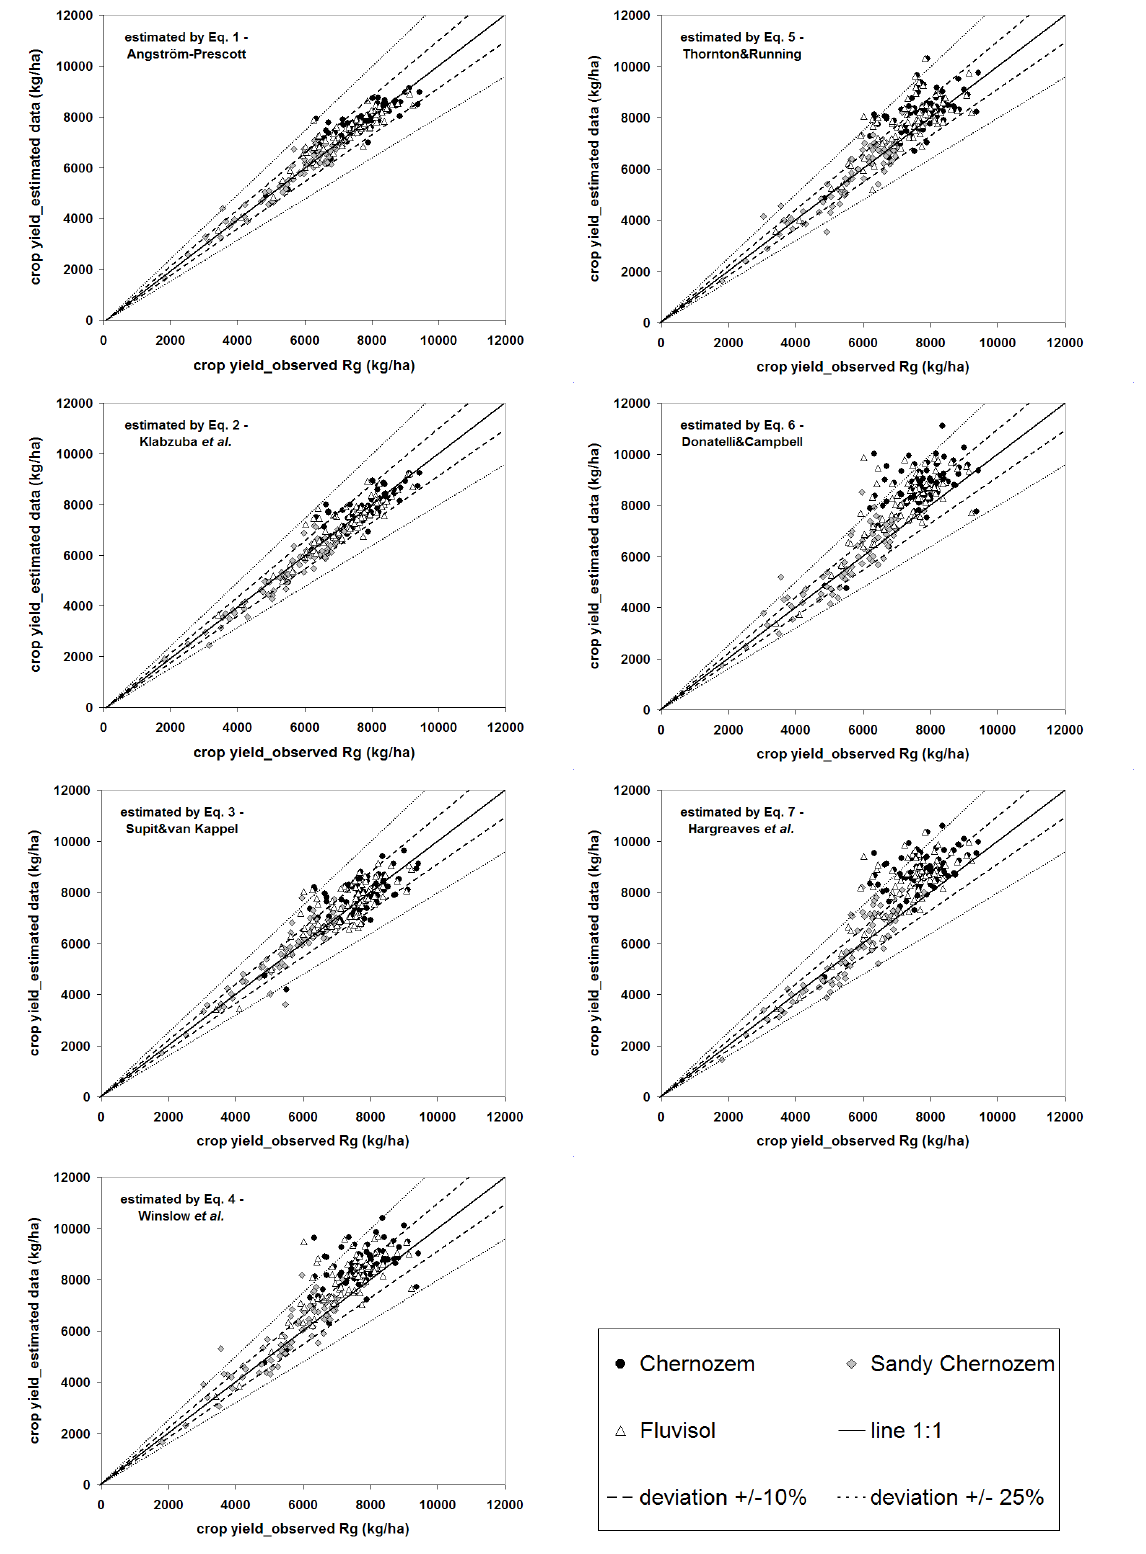
Figure 3. Scatter plot charts representing winter wheat yields (CERES-Wheat) during individual seasons simulated using observed R and those estimates by Eqs. (1)-(7). G The results of simulations at three soil types are presented at each